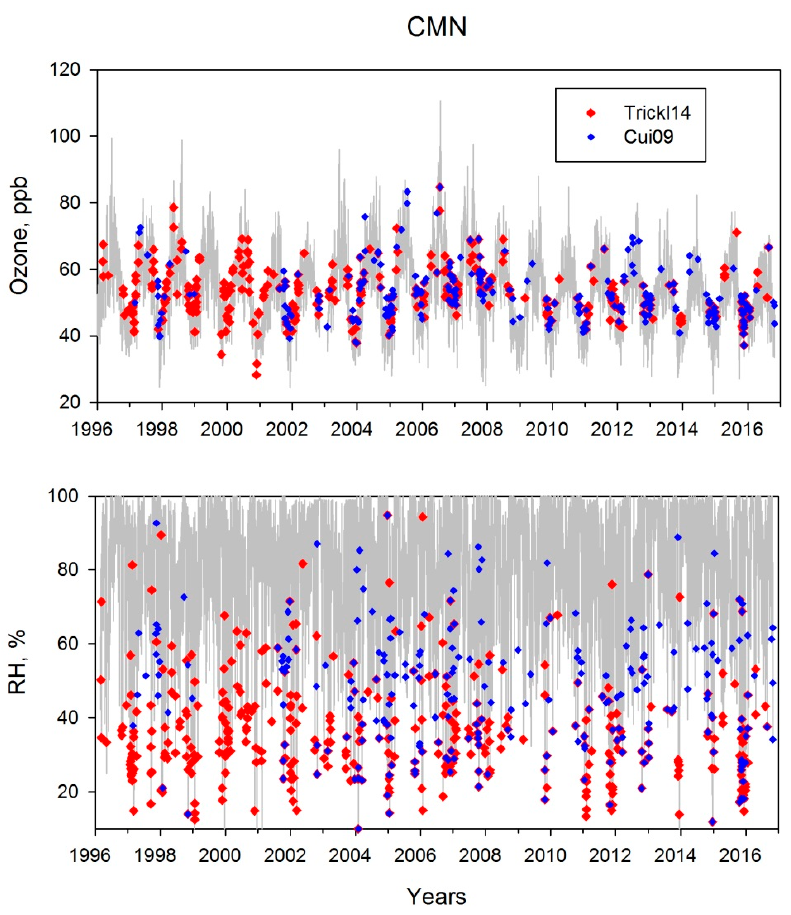
Figure 2. Measured O 3 (top) and RH (bottom) daily values at CMN (grey lines). Red (blue) dots indicate measurement periods identified as SI by the “Cui09” (“Trickl14”) criterion.